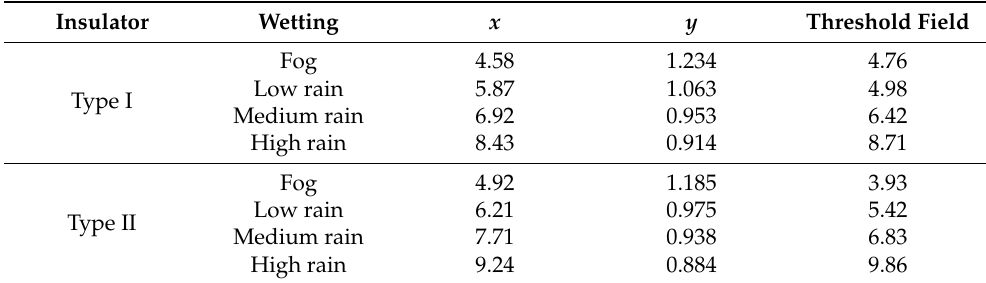
Table 3. The values of the fitting function parameters x and y under different wetting conditions.